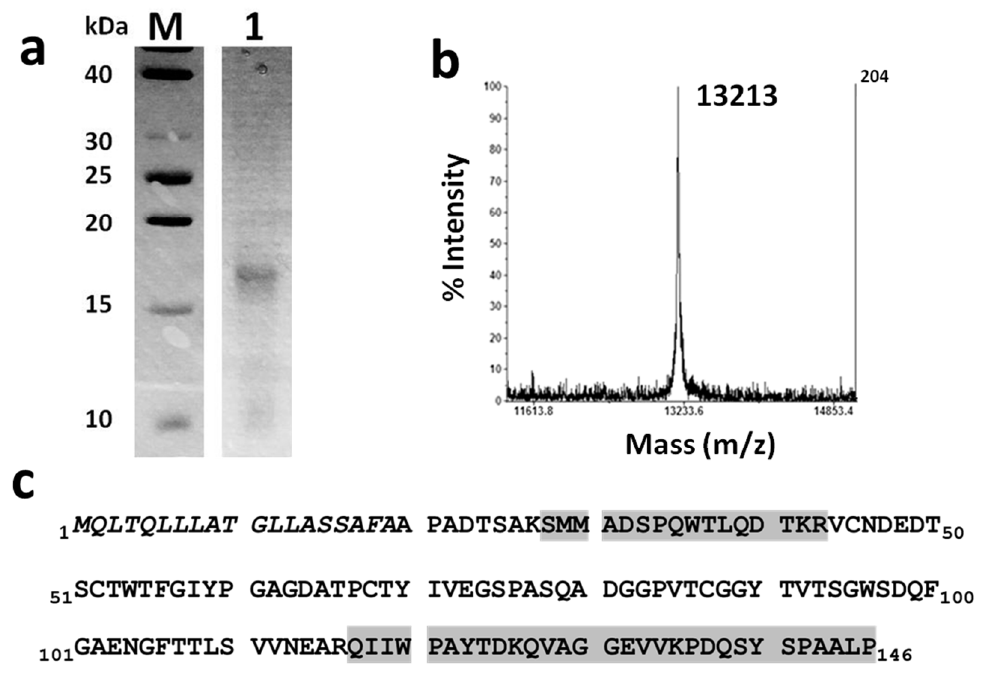
Figure 1. ( a ) SDS analysis of SAP -Pc in 60% ethanol solution after methanol chloroform treatment; ( b ) MALDI-TOF spectrum of SAP -Pc in 60% ethanol solution in linear mode; ( c ) sequence coverage of the primary structure of identified SAP -Pc highlighted in